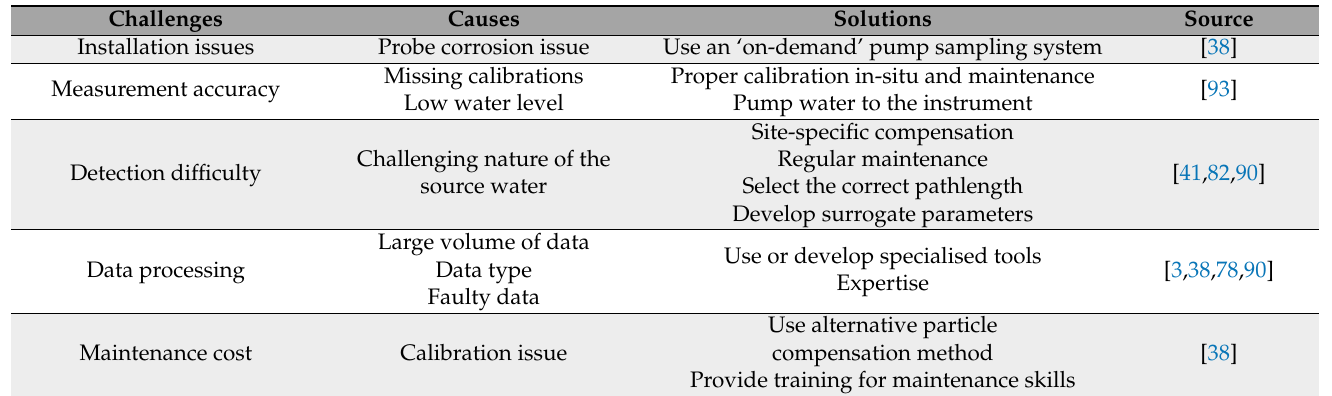
Table 4. Challenges and solutions of using the online UV-Vis